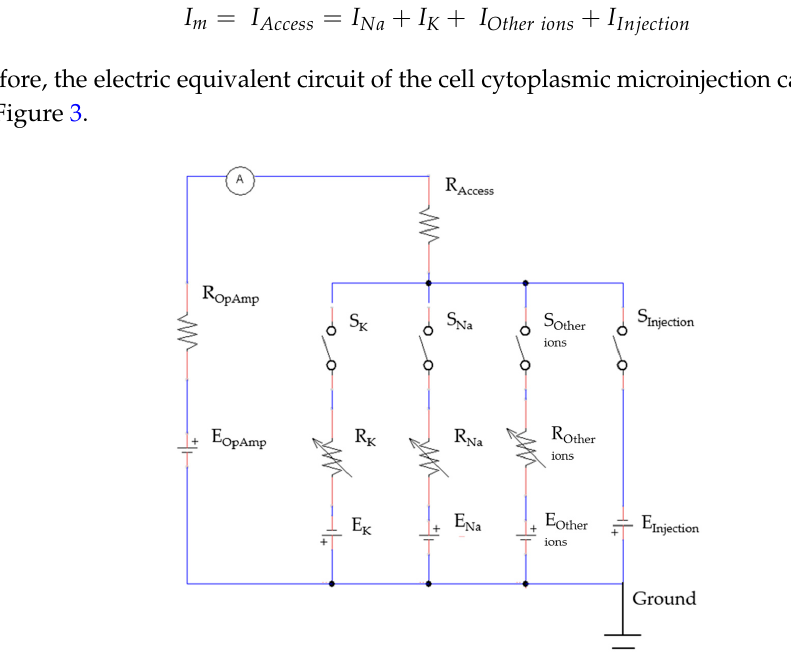
Figure 3. The simplified circuit of the current feedback model for the cell cytoplasmic microinjection and cell viability verification.